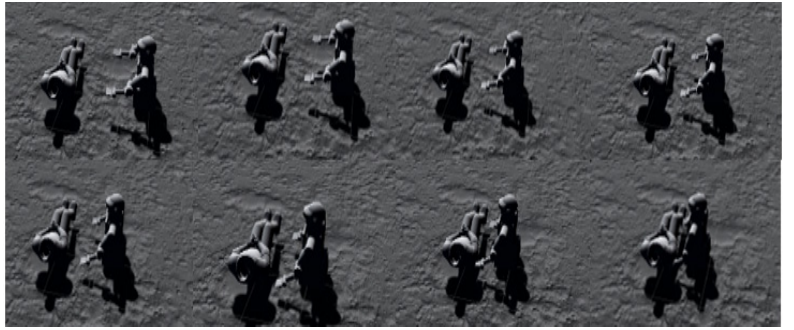
Figure 5. Simulation